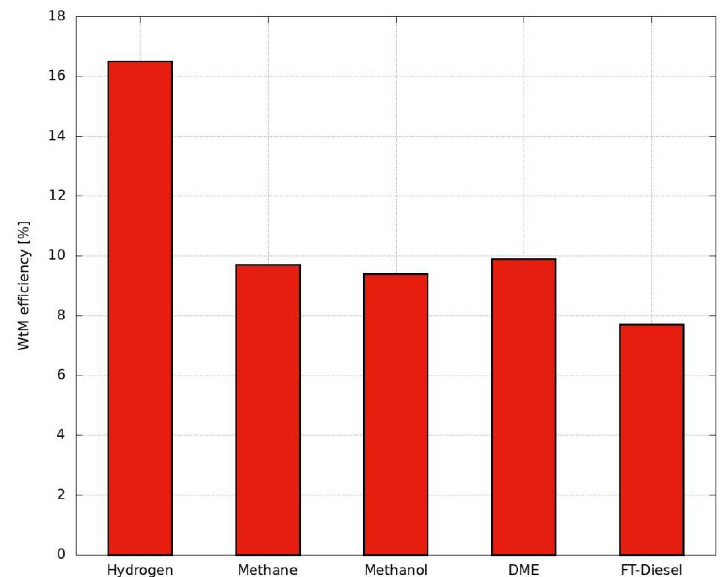
Figure 7. WtM efficiency (Data source [15]).